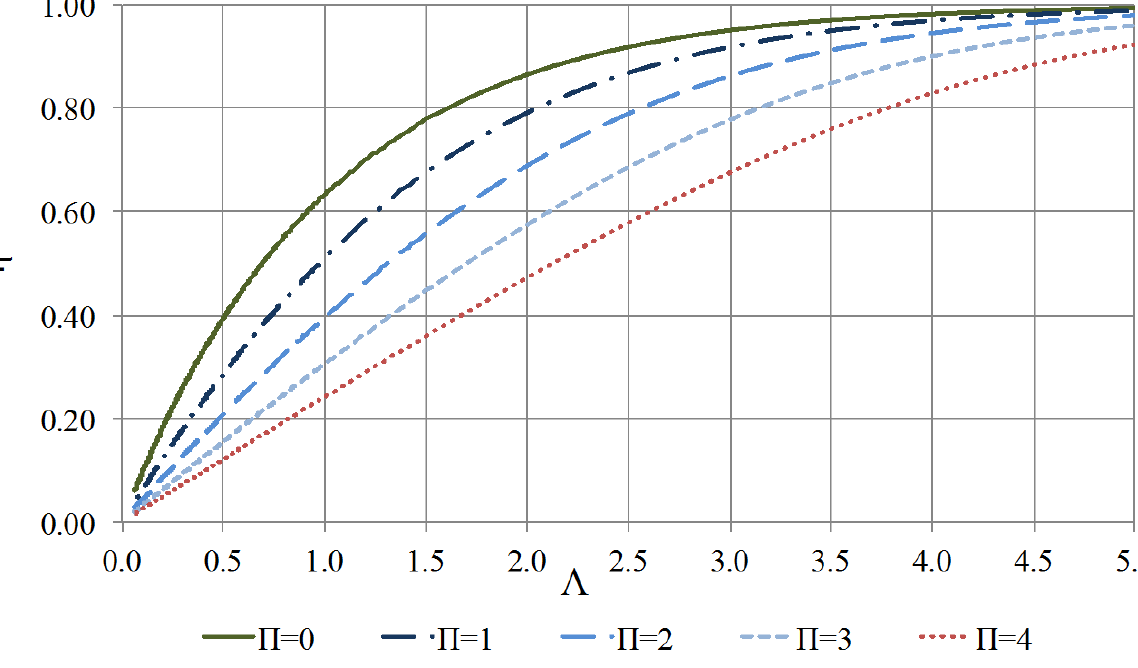
Figure 7. Regenerator